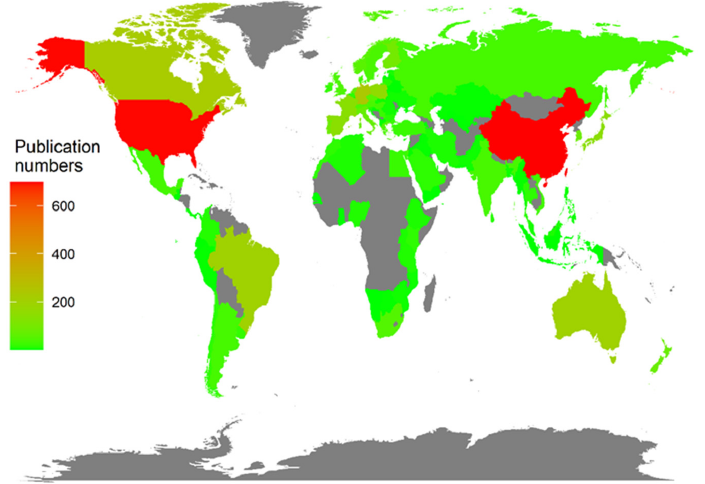
Figure 2. Number of articles published by authors in different countries. Gray color represents areas without publications.